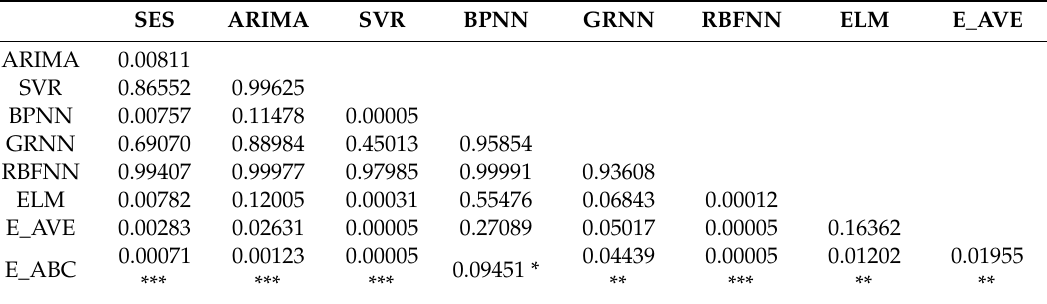
Table 5. DM statistical test